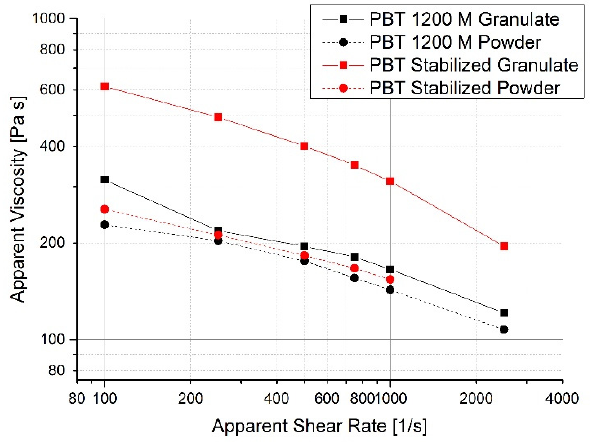
Figure 9. Apparent viscosity of PBT granulates and powders at 250 °C.